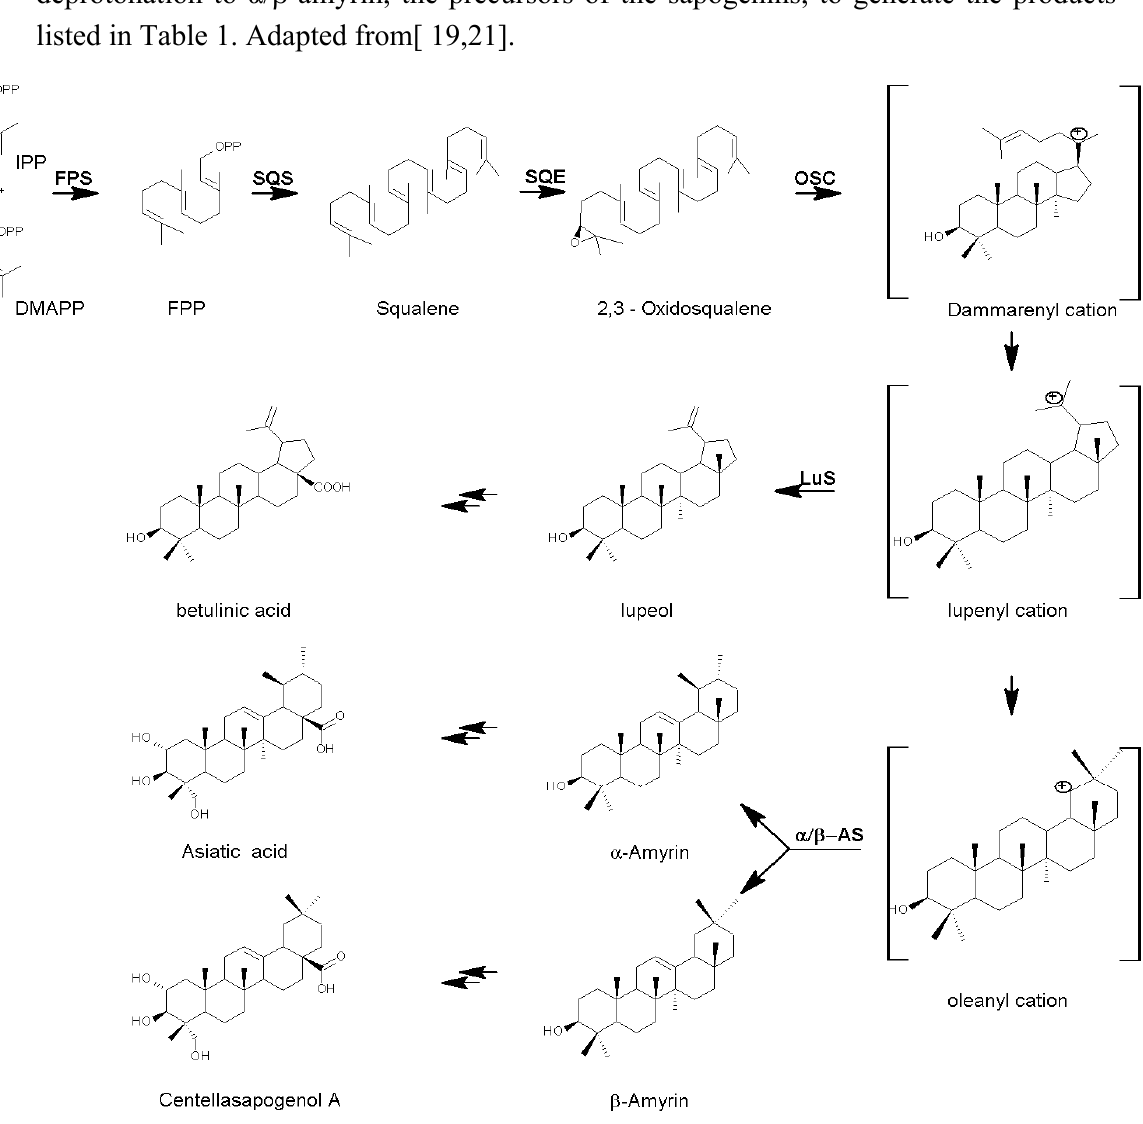
Figure 2. A simplified scheme of triterpenoid biosynthesis in Centella .